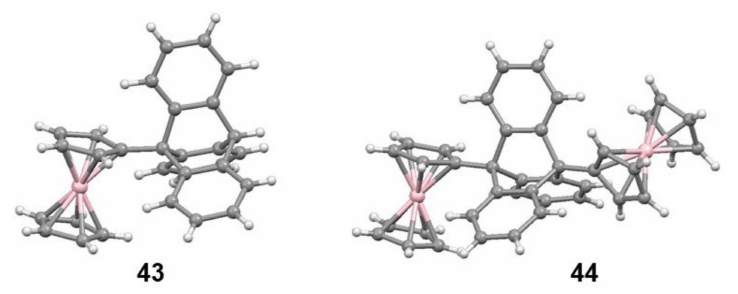
Figure 19. Structures of 9-ferrocenyltriptycene, 43 , and rac -9,10-diferrocenyltriptycene, 44